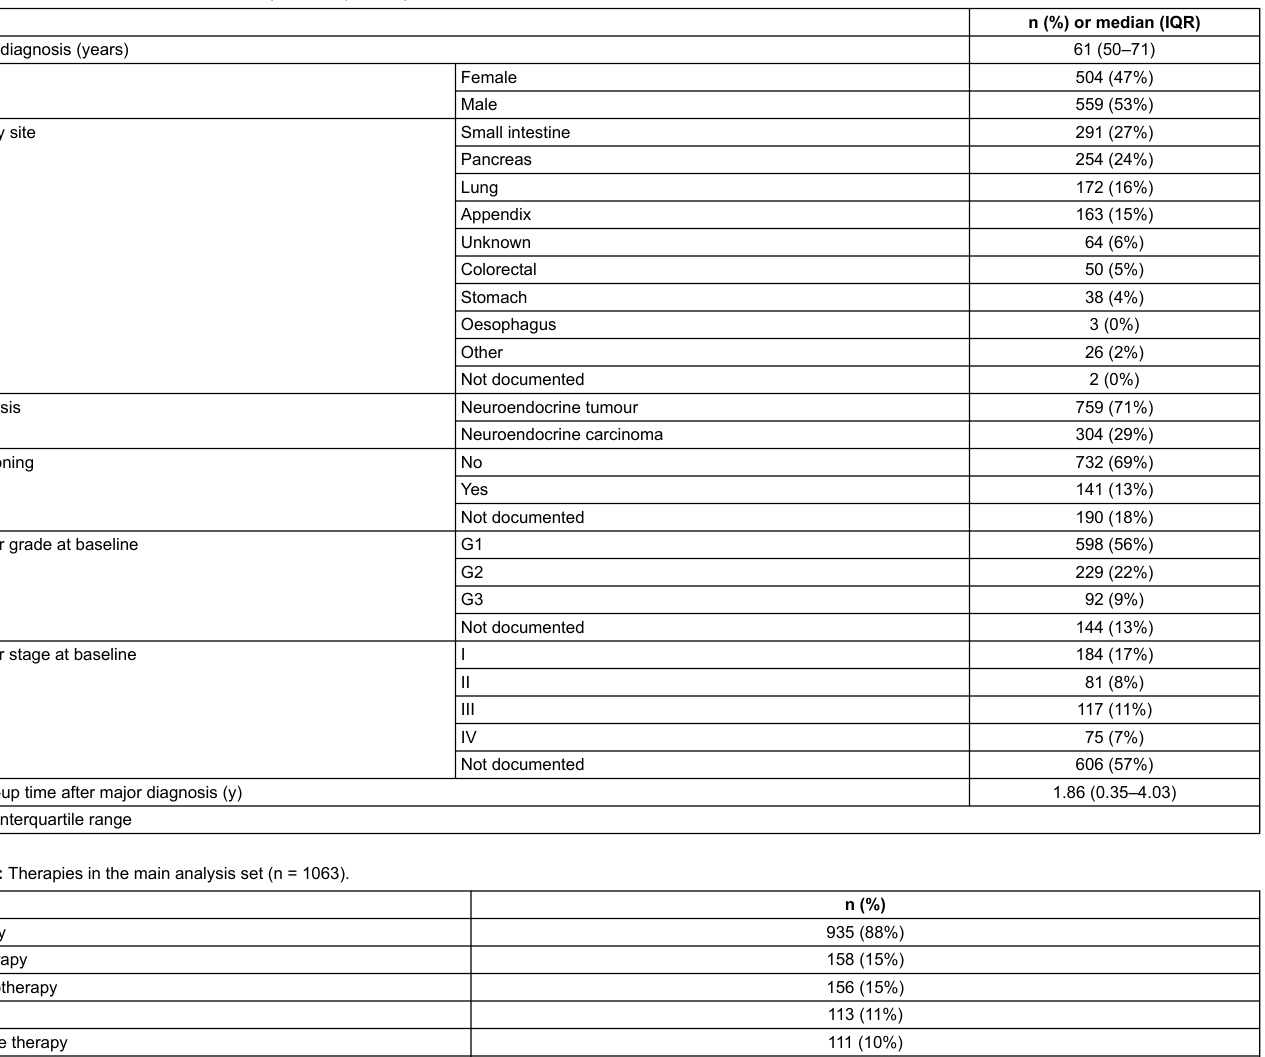
table 5. Fifty-six patients (19%) with small intestinal NETs